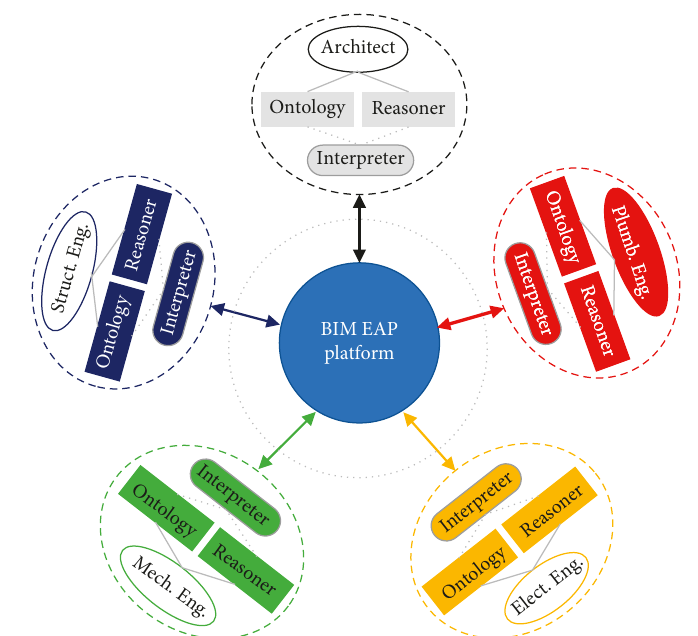
Figure 10: A hypothetical setting for the office building